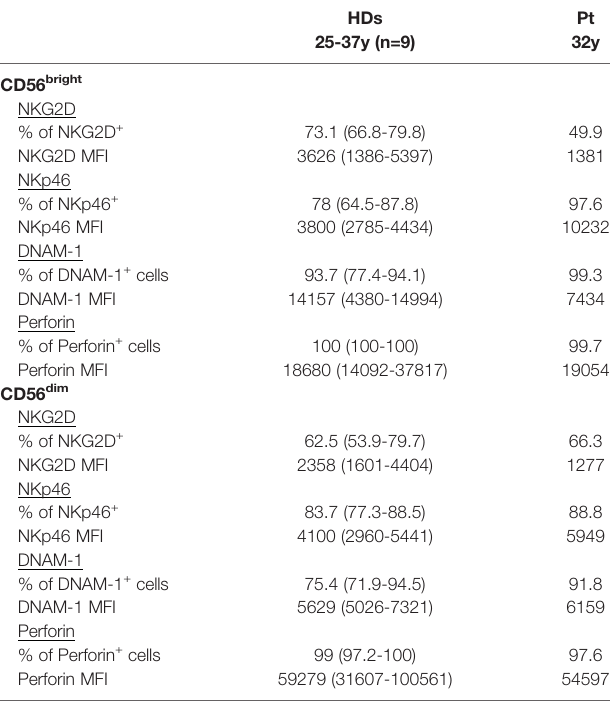
TABLE 2 | NK-cell activating receptors and perforin pro fi le.